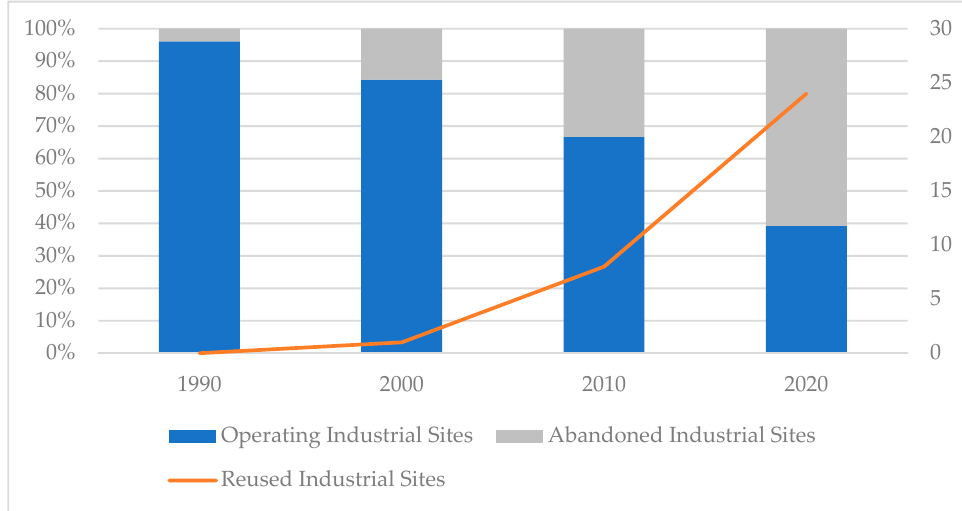
Figure 31. The change in the operation state of 51 industrial heritage sites in Nanjing over time (Figure source: own drawing; data source: on-site investigation).